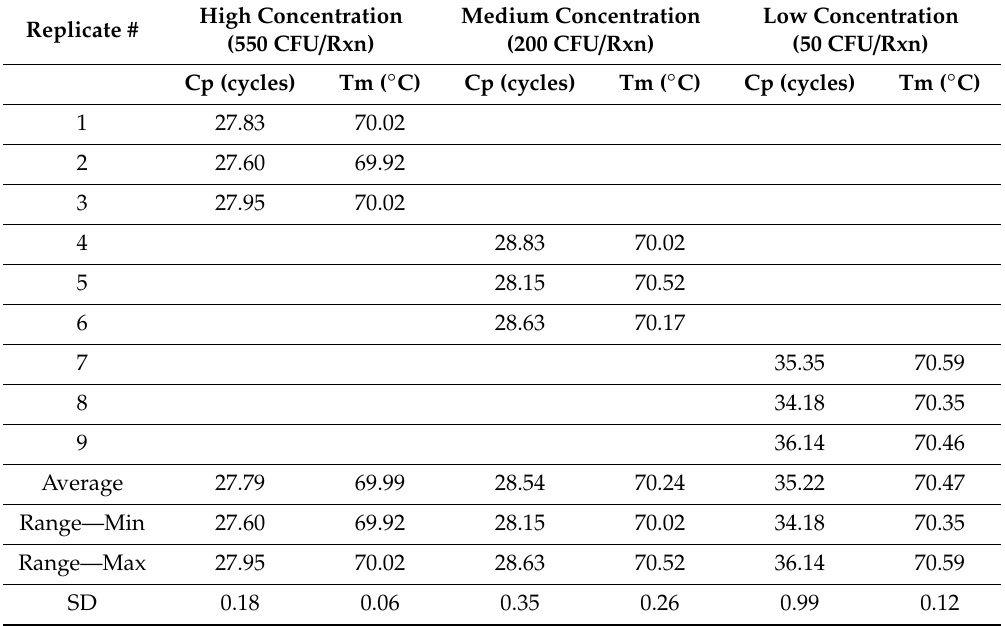
Table A2. Intra-day precision: 3 replicates tested at 3 concentrations (high, medium, low) on the same day.